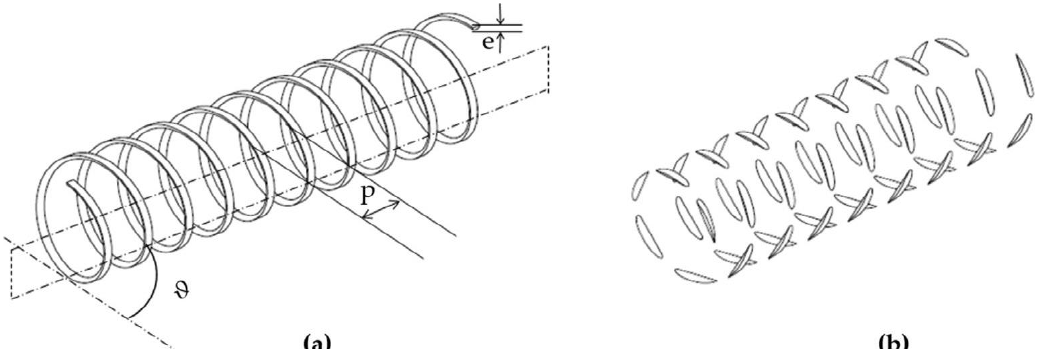
Figure 14: Schematic of continuous and discontinuous helical turbulators: (a)RIB-1 (b)RIB-2 [22].